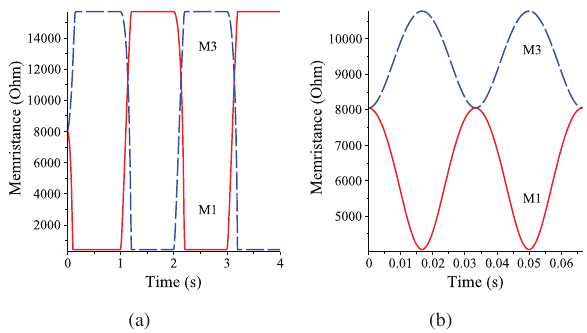
Fig. 4 : Memristances M 1 and M 3 dependent on time t , sine AC voltage source, V 0 = 30 V , x n ( t = 0 ) = 0 . 5 , (a) f = 0 . 5 Hz , (b) f = 30 Hz .